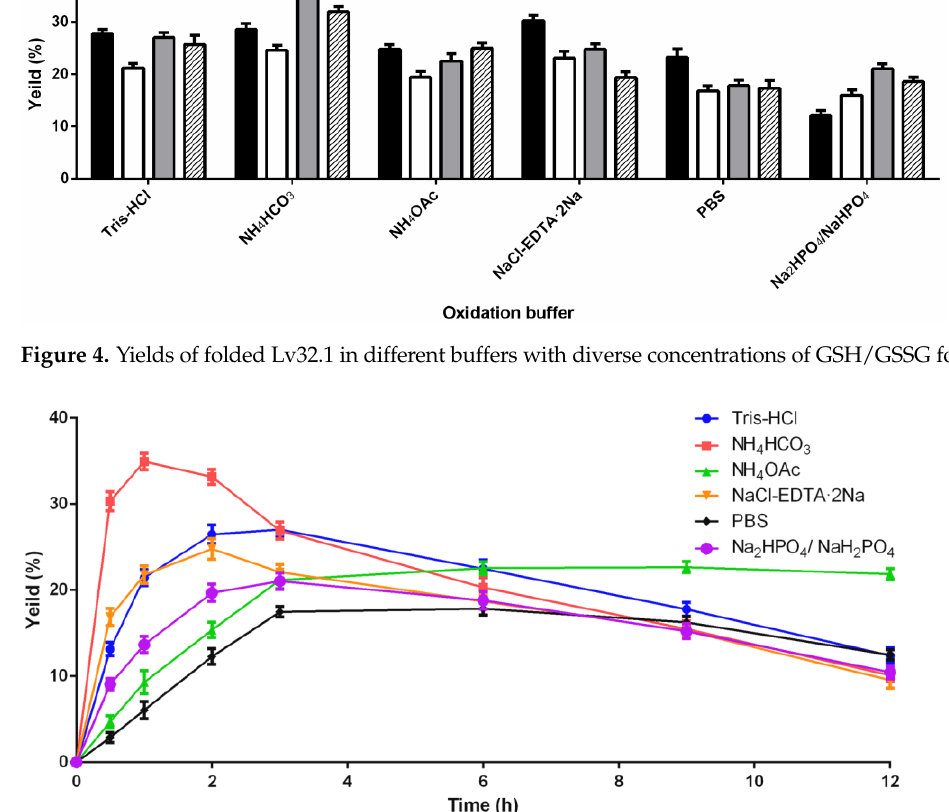
Figure 5. Yields of folded Lv32.1 in different buffers with GSH/GSSG (1 mM/0.5 mM) at progres- sive reaction times .